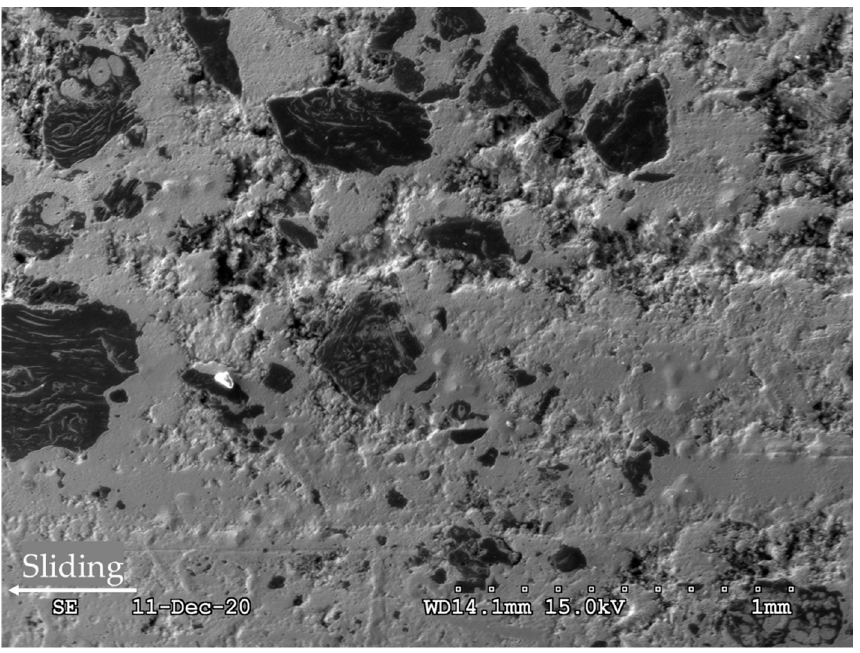
Figure 10. Worn surface of an LS pad. SEM secondary electrons image.